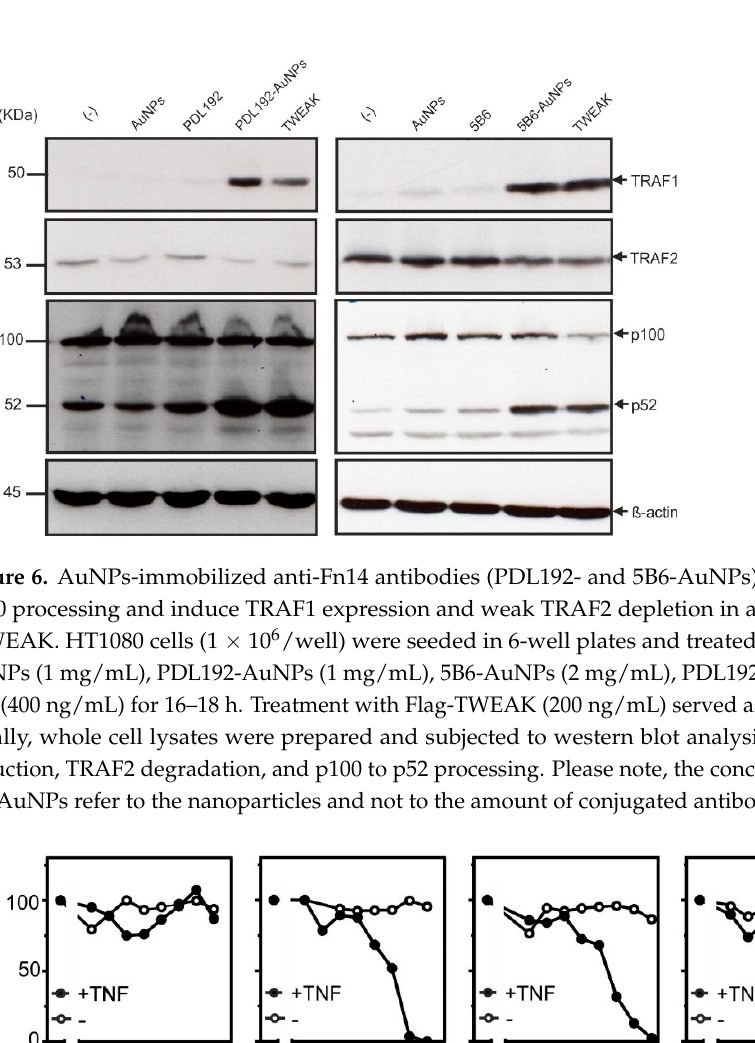
Figure 7. AuNP-immobilized anti-Fn14 antibodies but not control AuNPs enhanced TNF-induced necroptosis in FADD-deficient HeLa-RIPK3 cells. Hela-RIP3-FADD KO cells (20 × 10 3 /well) were seeded in 96-well tissue plates. The next day, cells were treated in the presence or absence of TNF (1 ng/mL) with the indicated concentrations of AuNP-immobilized PDL192, AuNP-immobilized 5B6, AuNPs, or Flag-TWEAK to trigger TNF-induced cell death. Cell viability was determined after 18 h via crystal violet staining. Please note, the concentration values of the AuNPs refer to the nanoparticles and not to the amount of conjugated